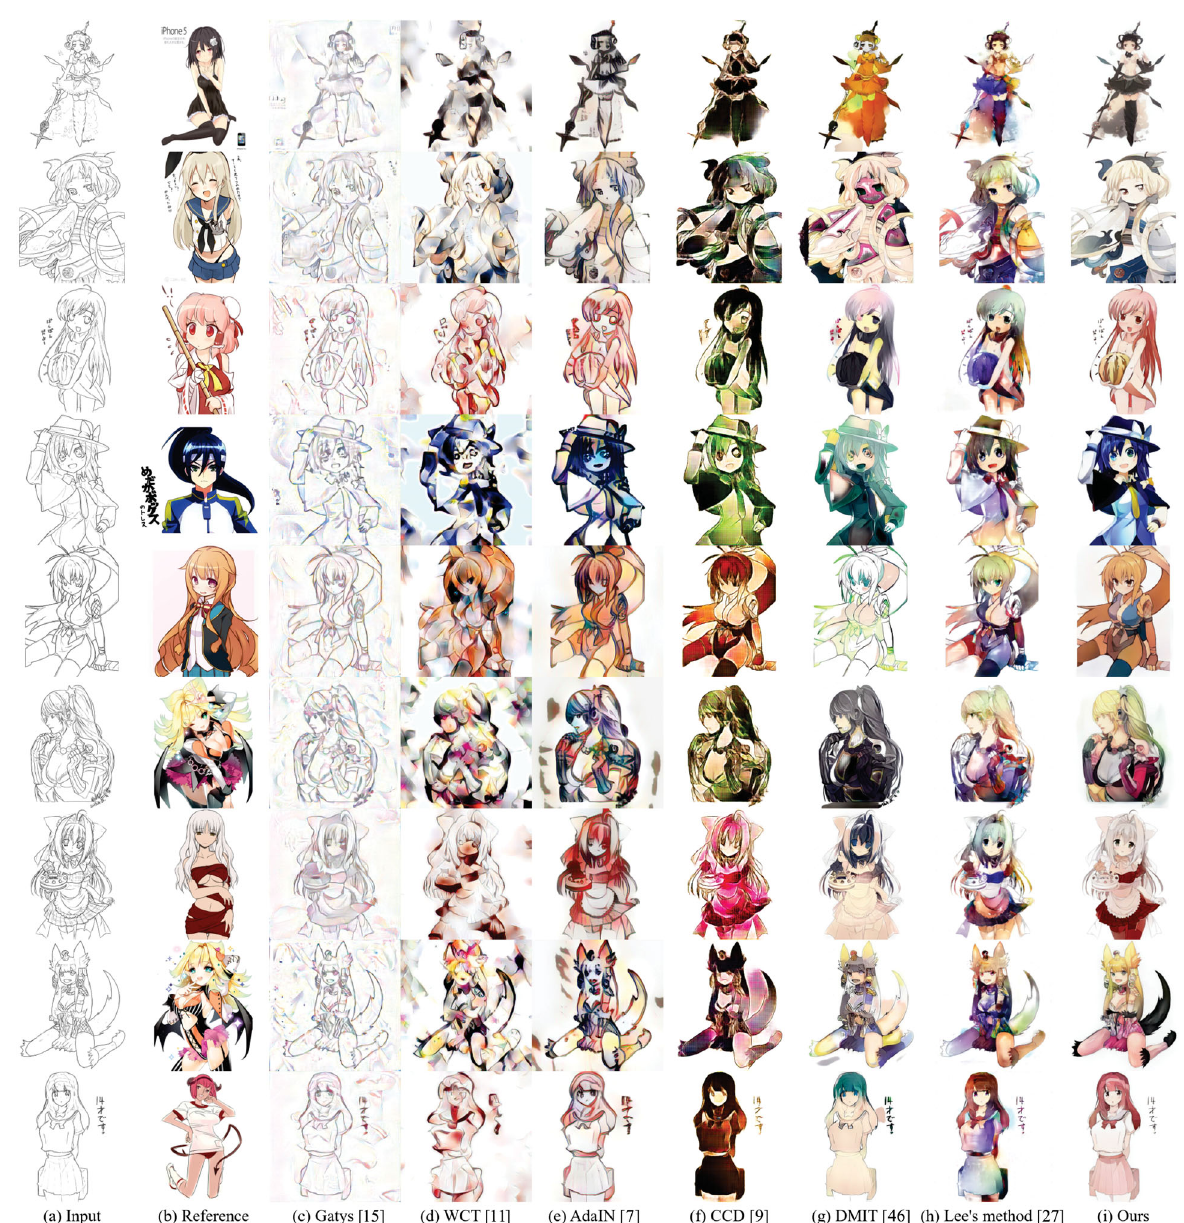
Fig. 5 Visual comparison between our method and state-of-the-art image style transfer methods, style-content disentanglement methods, and conditional sketch